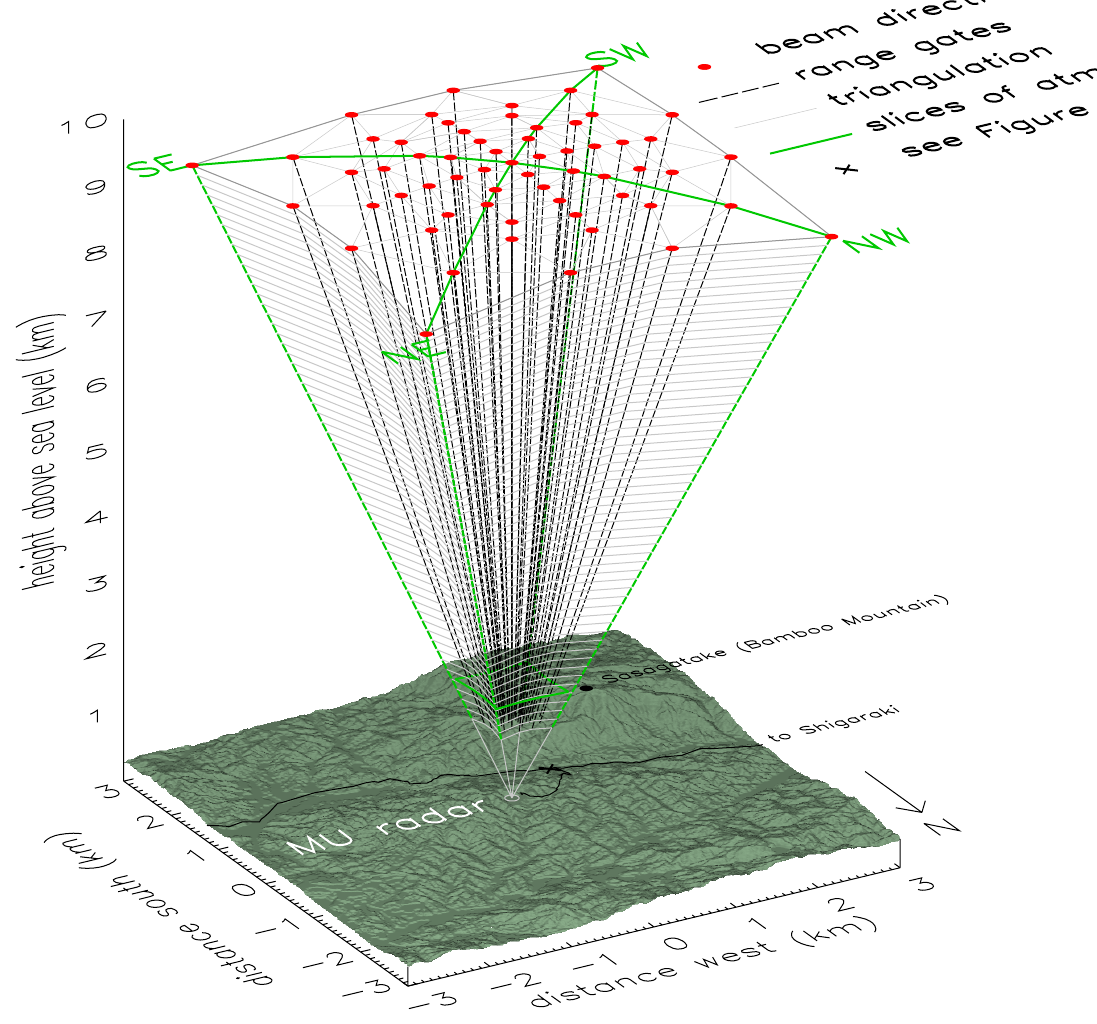
Fig. 2. Three-dimensional view of MU radar transmitting in volume-imaging mode, to scale. Land height is 210–740ma.s.l. and the radar is 385m a.s.l. Green lines show horizontal and vertical slices plotted in Figs. 5, 6, 7, 9, 10 and